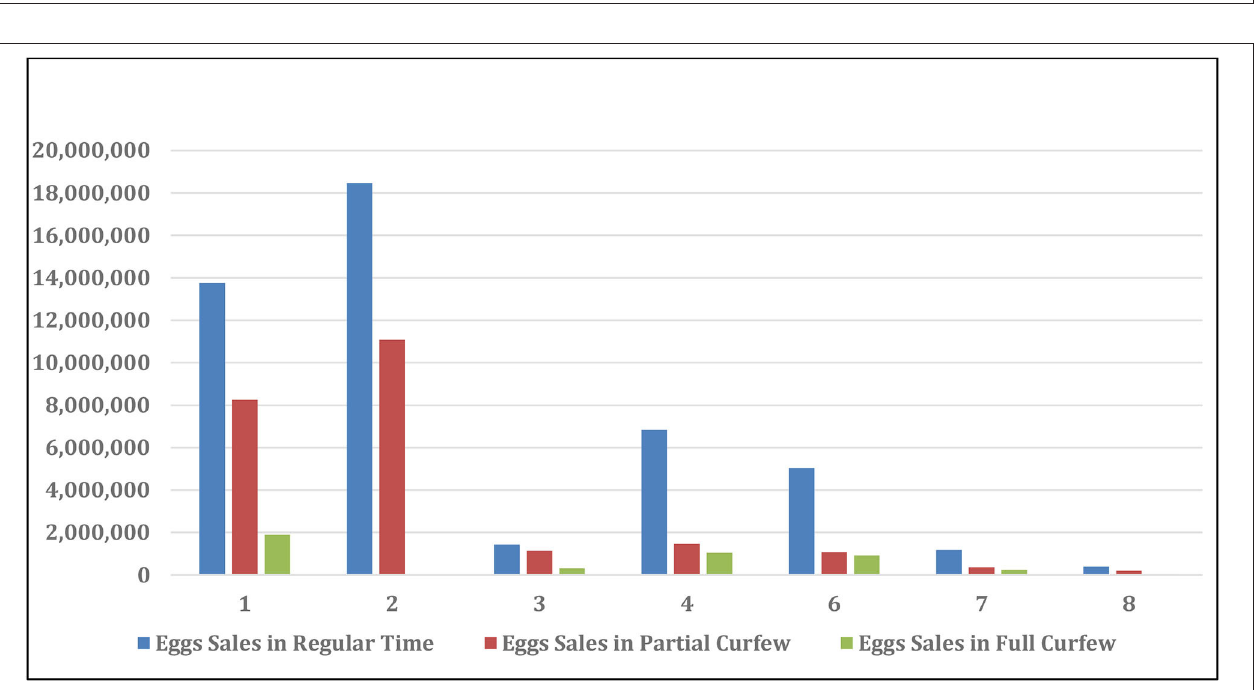
FIGURE 3 | Chicken sales in USD before and after SARS-Con-V2 crisis.